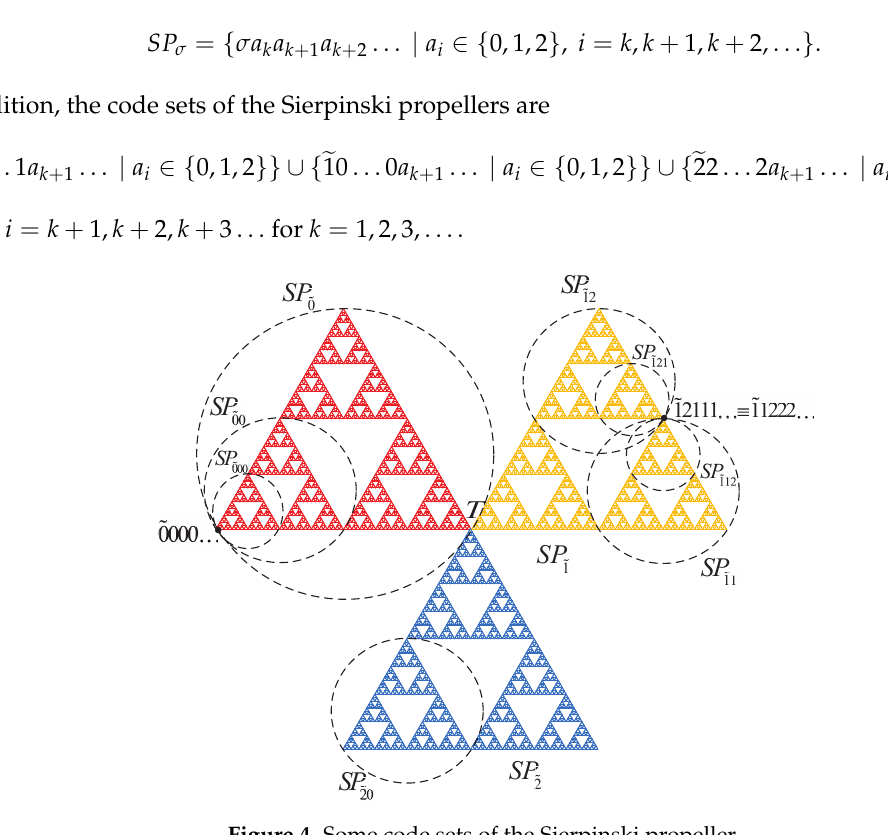
Figure 4. Some code sets of the Sierpinski